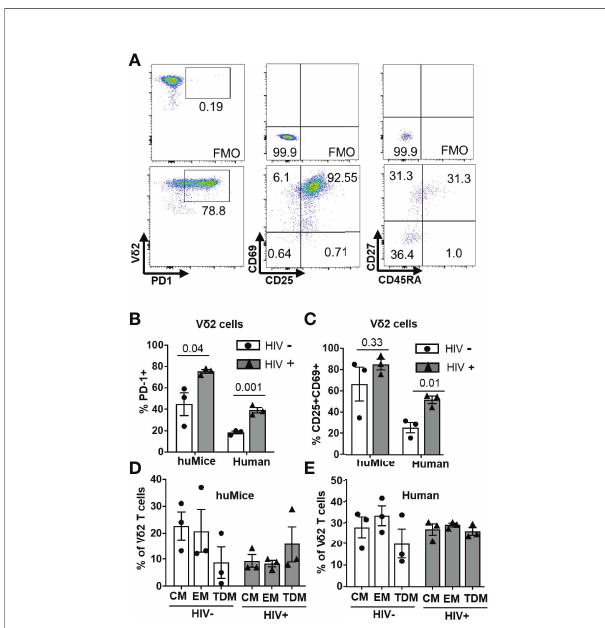
FIGURE 6 | Phenotypic characterization of cultured V d 2 cells. The phenotype of V d 2 cells from 6 BLT huMice and 6 HIV-positive/negative individuals after the expansion was analyzed by fl ow cytometry. (A) Representative fl ow cytometry analysis of expanded V d 2 cells from splenocytes of humanized mice expressing activation, inhibitory, and differentiation markers. (B) Expression of the checkpoint inhibitory marker PD-1 on V d 2 cells expanded from HIV-infected and non-infected BLT huMice and humans. (C) Dual expression of activation markers CD69 and CD25 on V d 2 cells expanded from HIV-infected and non- infected BLT huMice and humans. (D) Percentage of V d 2 cells de fi ned as central memory (CM) (CD45RA – CD27 + ), terminally differentiated (TDM) (CD45RA + CD27 – ), and effector memory (EM) (CD45RA – CD27 – ) derived from HIV-infected and non-infected BLT huMice. (E) Percentage of V d 2 cells derived from HIV-positive and HIV-negative individuals de fi ned as having EM, CM, TDM phenotypes. Data are presented as mean values ± SEM. P values were determined using two-tailed unpaired t-tests between the two